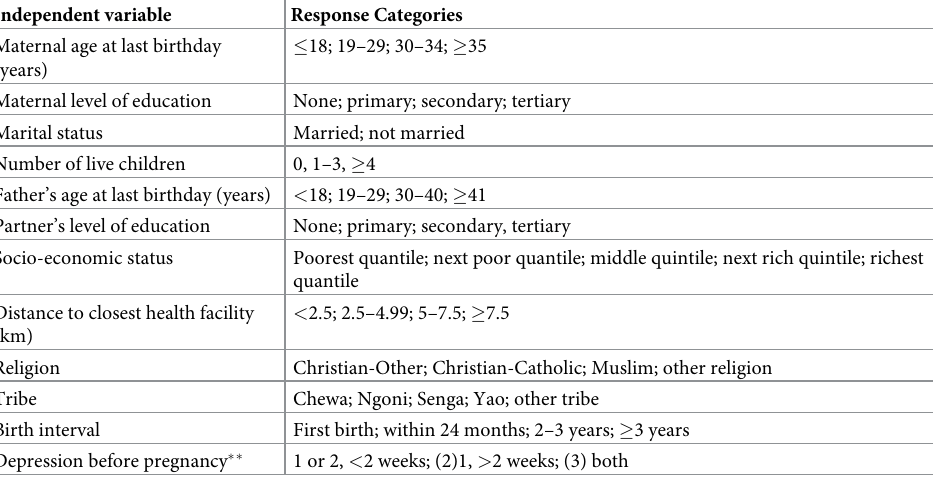
Table 1. List of independent variables with potential to influence pregnancy